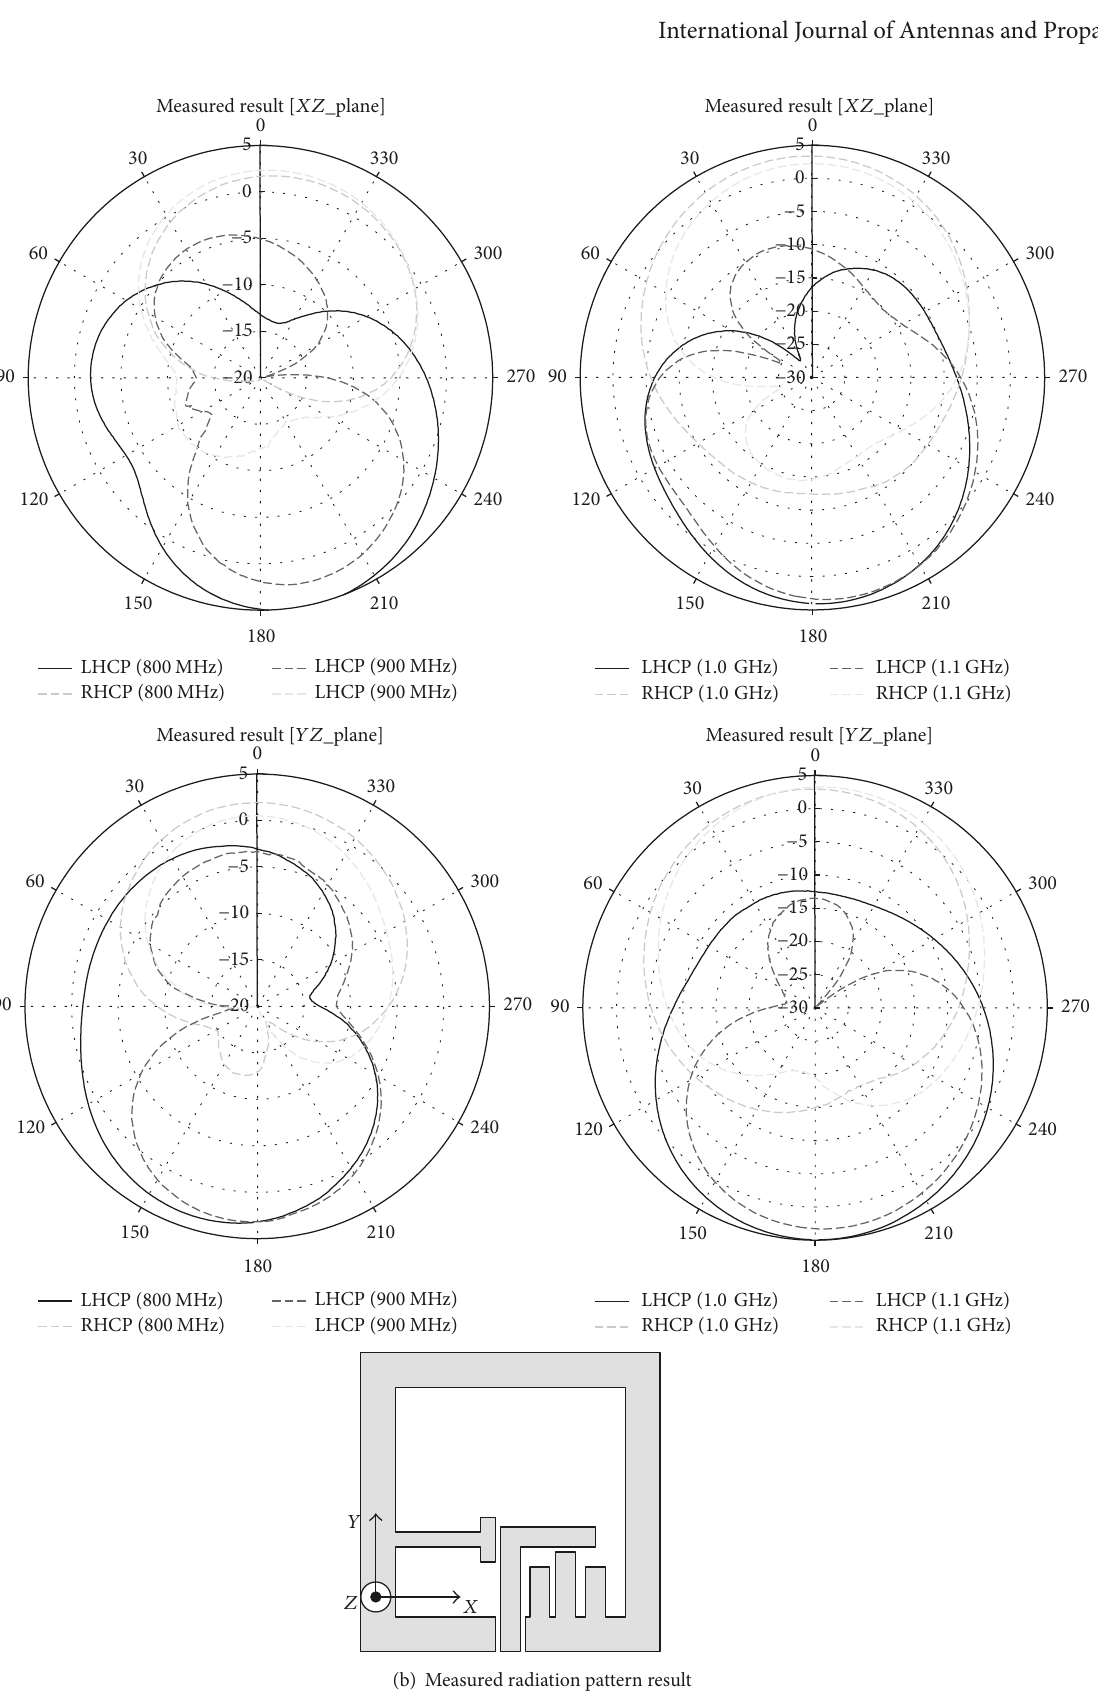
Figure 8: Radiation pattern of the manufactured